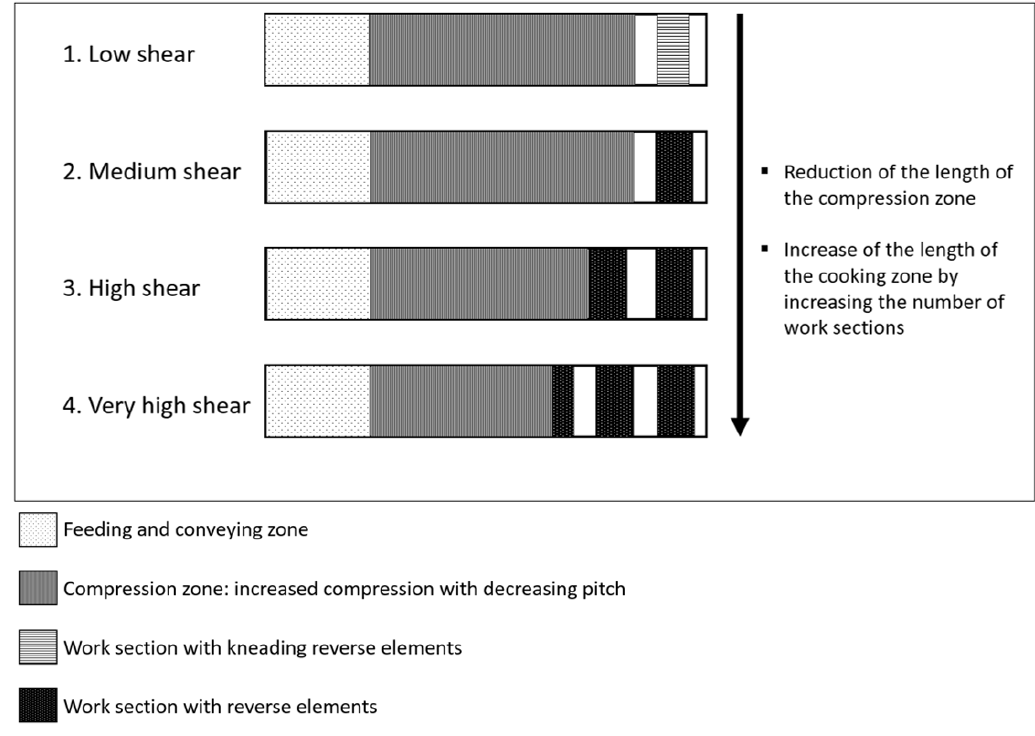
Figure 1. Graphical representation of the low shear, medium shear, high shear and very high shear screw configurations in the extruder.